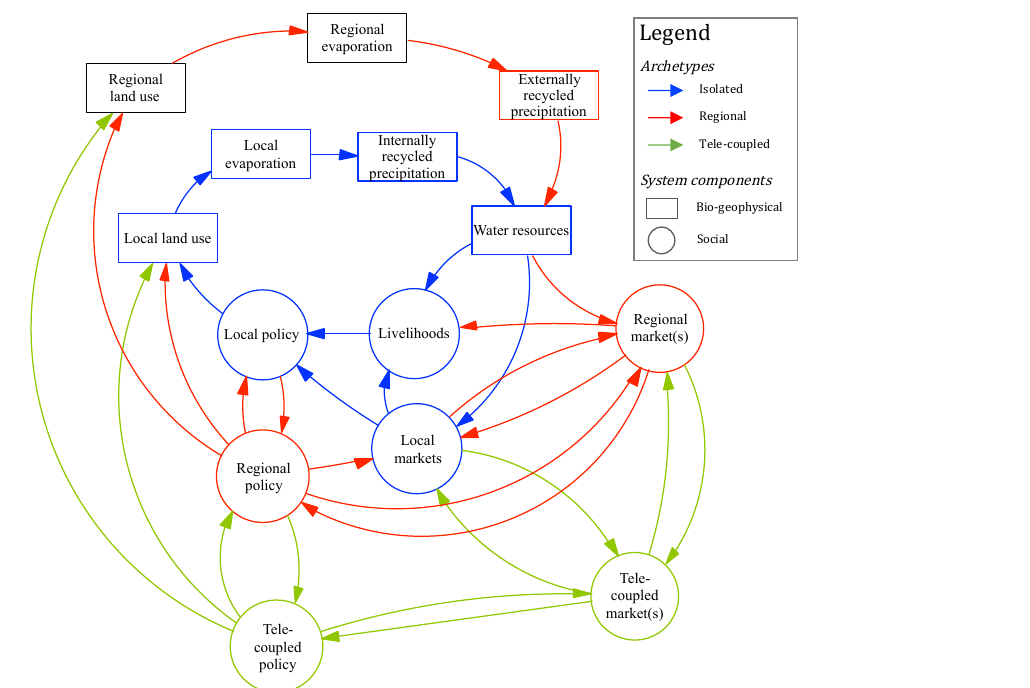
Figure 5. Archetypes of moisture-recycling social ecological system (MRSES), with blue corresponding to “isolated”, red to “regional”, and green to